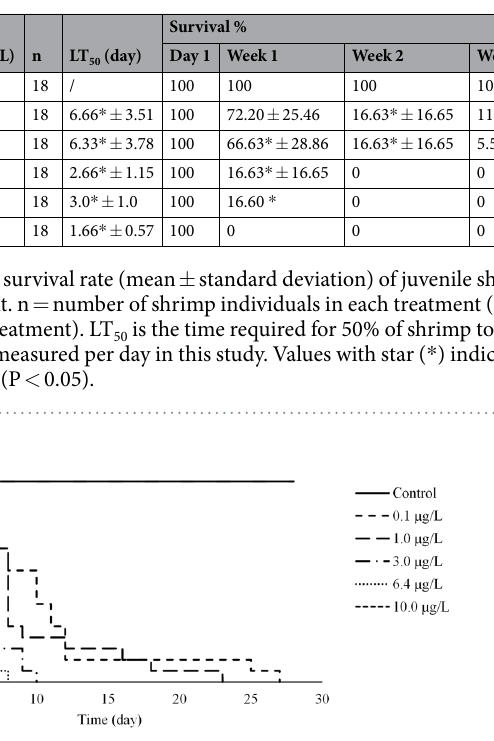
Figure 2. Kaplan-Meier survivorship curves of juvenile shrimp under different concentrations of fipronil during 29 days of exposure. Day 1 is 24-h after the beginning of the experiment. All treatments were